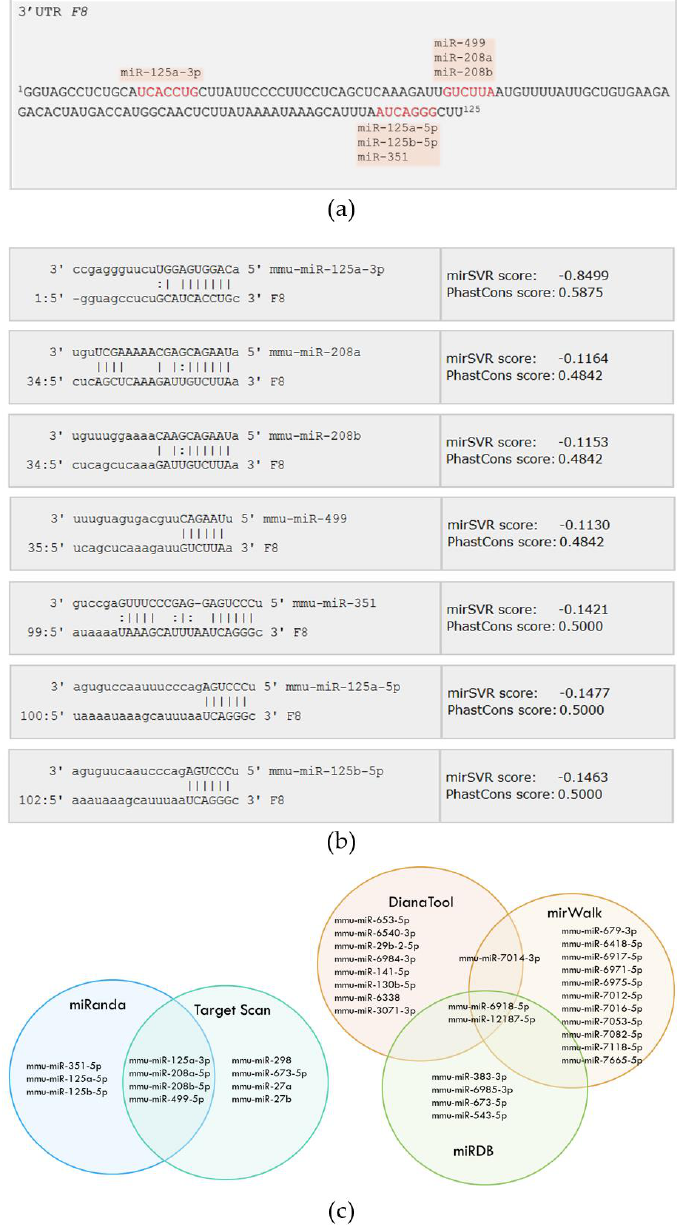
Figure 1. Target gene analysis. ( a ) mRNA sequence of murine 3′untranslated region (3′UTR) of the F8 region aligned with miRNAs that have potential target sites in F8 highlighted by red font. ( b ) Sequence alignment of selected miRNAs and mu F8 -mRNA with potential target sites in the 3′UTR of mu F8 predicted by miRanda (microrna.org). ( c ) Murine MiRNAs (mmu-miRNA) predicted to target mu F8 3′UTR by five different prediction algorithms (miRanda, Target Scan, MiRDB, Diana Tools and mirWalk) and displayed by Venn diagrams.